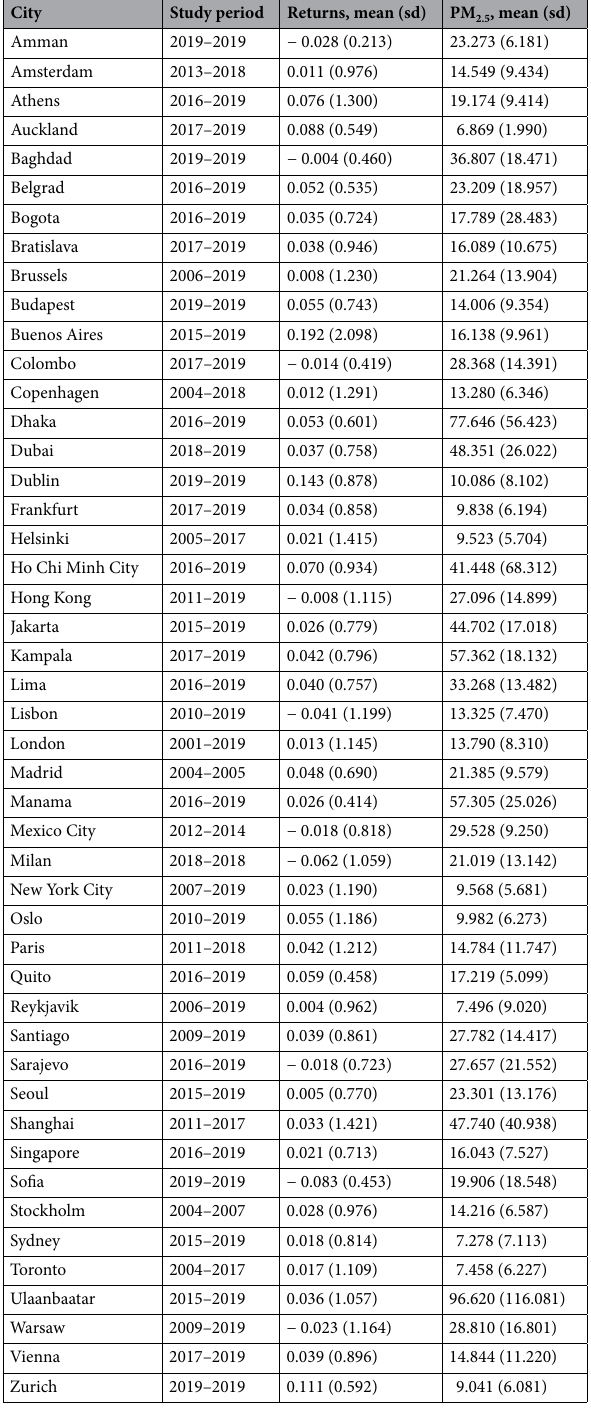
Table 2. Characteristics of the 47 stock market cities included in the present